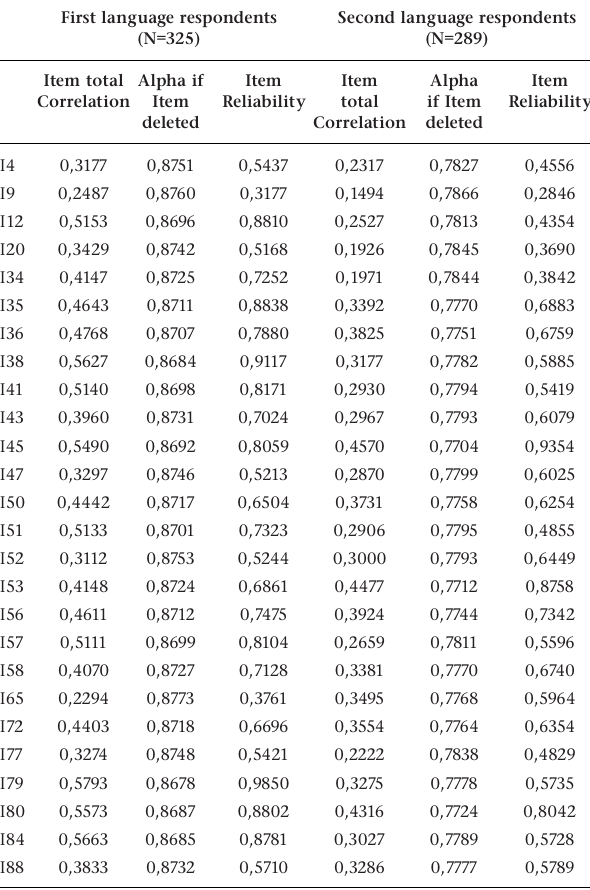
Figure 1 indicates that two significant factors can be identified for the second language respondents based on the results of the scree-test (Cattell, 1966) and Horn’s (1965) criterion. A clear break can be observed on the scree-plot between Factors Two and Three. The eigenvalues of the random data set intersect the eigenvalues for the true data set between Factors Two and Three for the second language group, indicating two significant factors (Horn, 1965). The results reported in Table 6 indicate that the two significant factors explain 36,21% of the total variance. Kaiser’s (1961) criterion clearly overestimates the number of true factors for the data set (Tabachnick and Fidell, 1989). According to Table 6. there are clear signs of over-factoring, as limited items loaded above 0,30 on Factor Three. The proposed three- model structure for the second language respondents is not well-defined or interpretable and does not resemble a simple structure. It is evident from the results that the three-factor structure proposed by Schepers (1999) did not hold for the second language